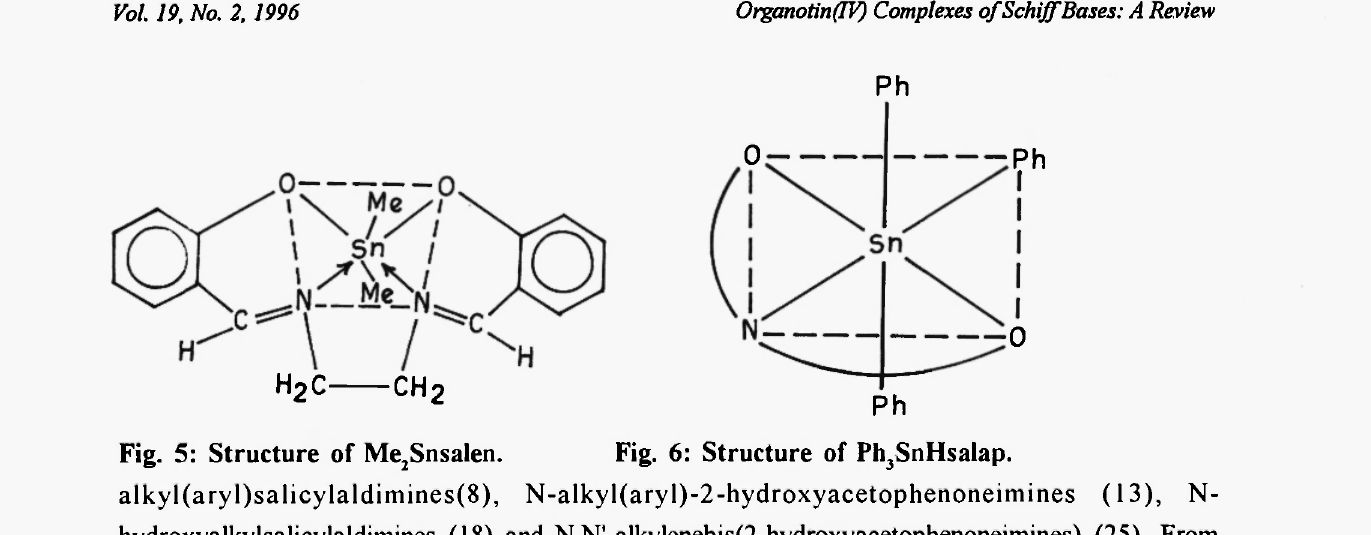
Fig. 5: Structure of Me Snsalen. Fig. 6: Structure of Ph 3 2